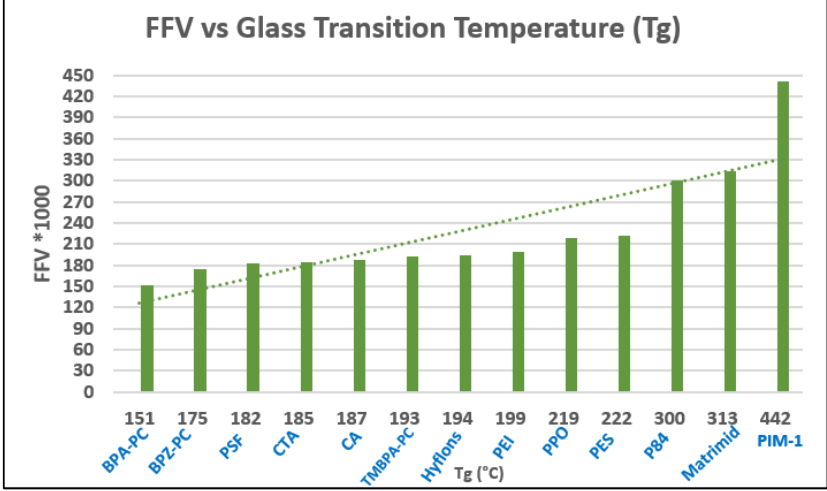
Figure 14. Relationship between FFV and Tg.